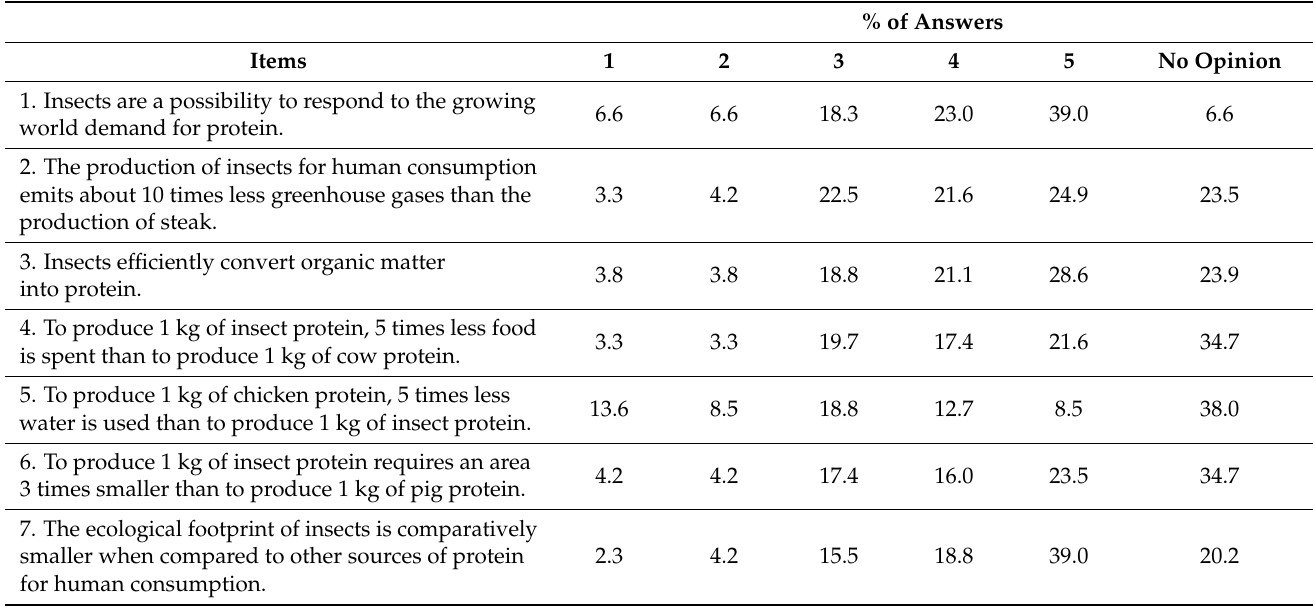
Table 5. Expressed opinions towards statements related with EI and sustainability (Scale from 1 = totally disagree to 5 = totally agree).